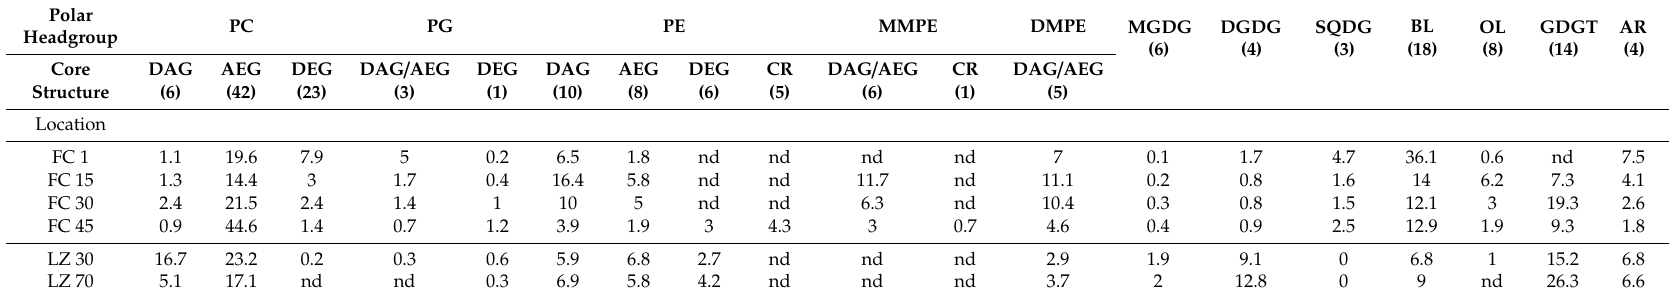
Table 1. Relative proportions of the intact polar lipid (IPL) groups, as determined by HPLC-ITMS. DAG: diacylglycerol, DEG: diether glycerol, AEG: mixed acyl / ether glycerol, CR: ceramides, PC: phosphocholine, PG: phosphoglycerol, PE: phosphoethanolamine, MMPE: monomethyl phosphoethanolamine, DMPE: dimethyl phosphoethanolamine, MGDG: monogalactosyldiacylglycerol, DGDG: monogalactosyldiacylglycerol, SQDG: sulfoquinovosyldiacylglycerol, BL: betaine lipid, OL: ornithine lipid, GDGT: glycerol dialkyl glycerol tetraethers, and AR: archaeol. The numbers in parentheses denote the number of di ff erent lipids within each group, di ff ering by carbon number. Location is abbreviated as FC: Fil ó n Centro, or LZ: La Zarza, with a number indicating depth; nd denotes not detected. Polar